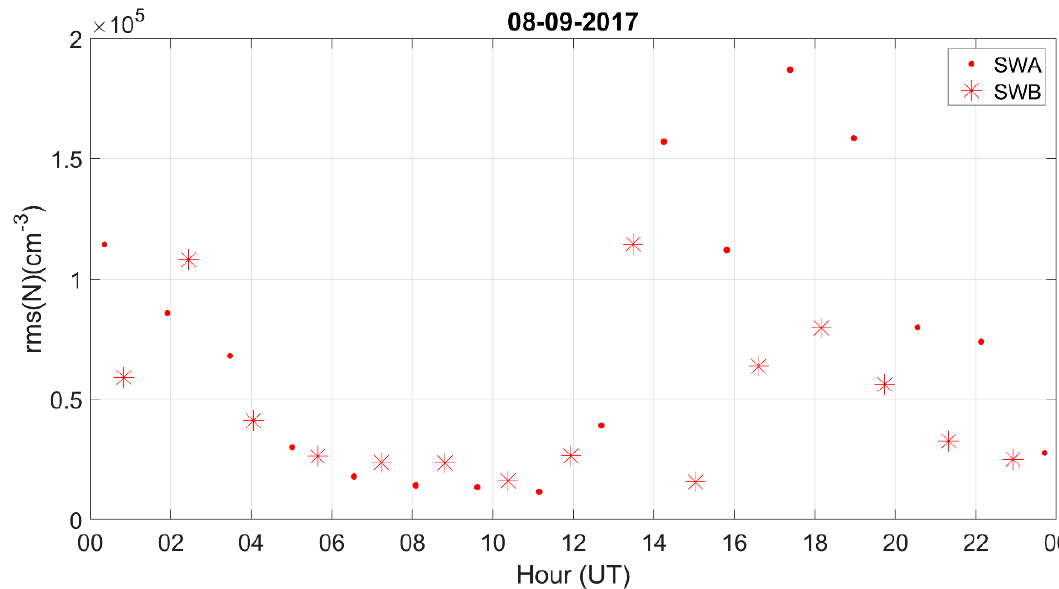
Figure 9. Electron density root mean square ( rms ) by Swarm A (dots) and Swarm B (stars) on 8 September 2017, in the Southern Hemisphere. The AACGM latitude ranges between 70° and 90° S.